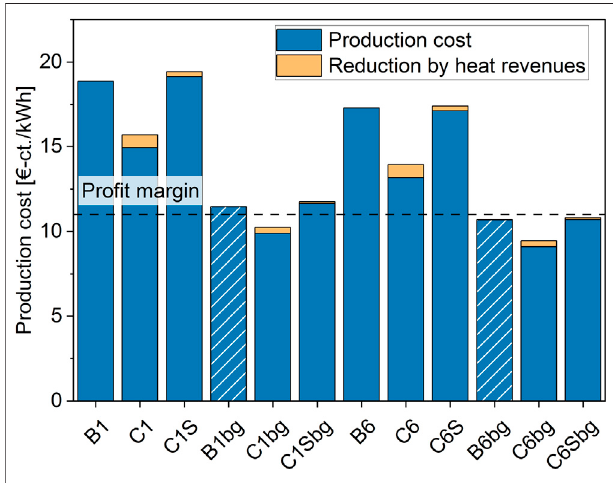
FIGURE7| Productioncostofbiomethaneforeachconsideredprocess under the base-case assumptions indicated in Supplementary Table S3 . The projected cost for biological methanation operated with biogas is indicated with shaded bars.